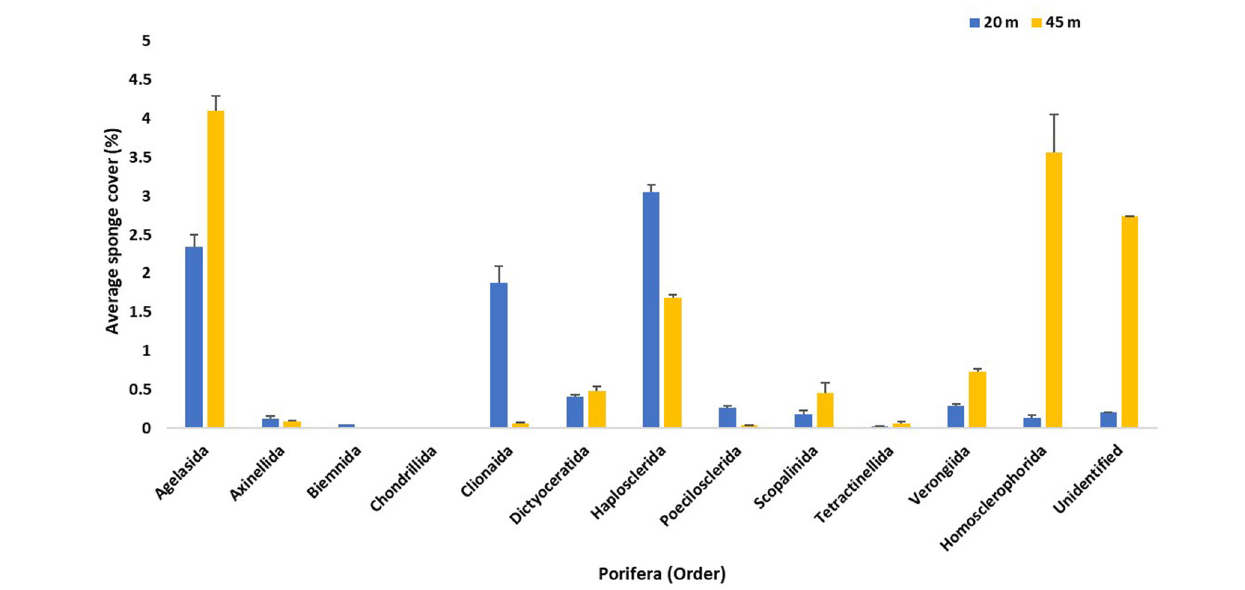
island of Puerto Rico (i.e., Culebra, Fajardo, Vieques